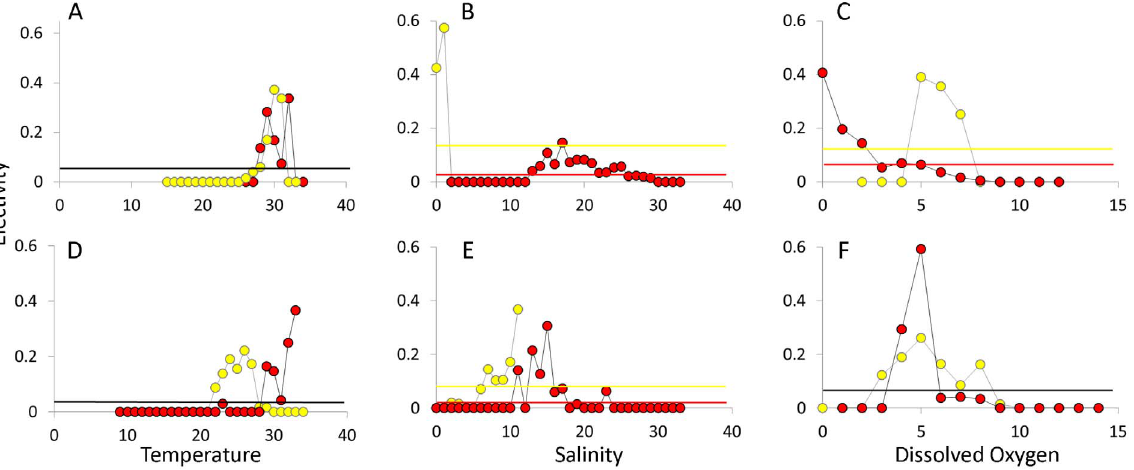
Figure 8. Bull shark electivity. Electivity plots for the lower (red) and upper (yellow) portions of Mobile Bay in 2009 (A–C) and 2010 (D–F). Electivity data are plotted for temperature (A, D) salinity (B, E) and dissolved oxygen (C, F). Horizontal lines represent neutral selection in the upper (yellow) and lower (red) bay. Horizontal black lines are used when the neutral selection value is the same between the upper and lower bay. doi:10.1371/journal.pone.0097124.g008 PLOS ONE |